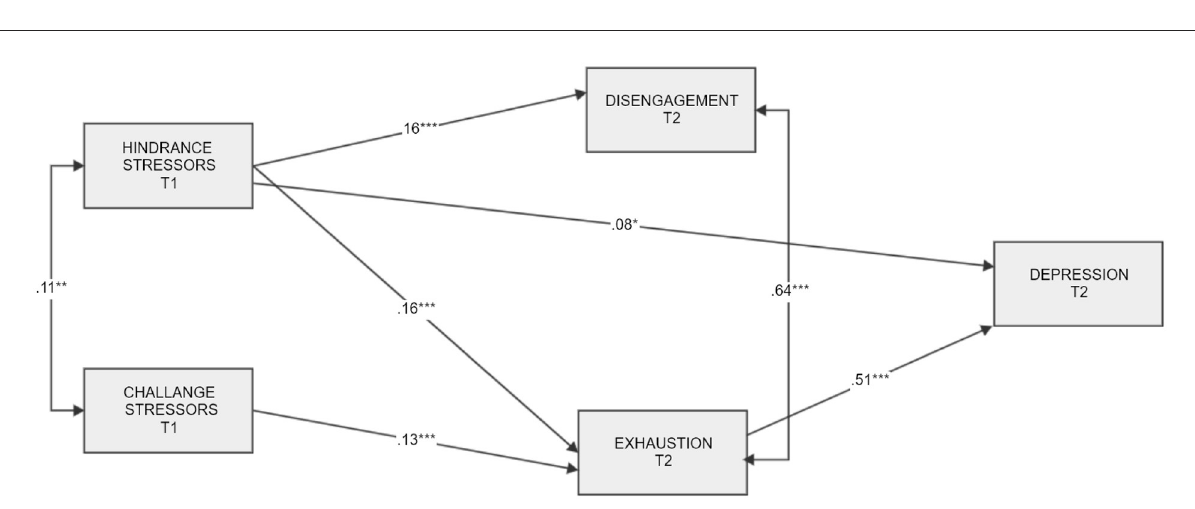
FIGURE2 Hypothesized final trimmed model of hindrance stressors and challenge stressors in time 1 as predictors of depression in time 2 mediated by burnout levels. Standardized coefficients are presented. “T”, time. * p < 0.05, ** p < 0.01, *** p <